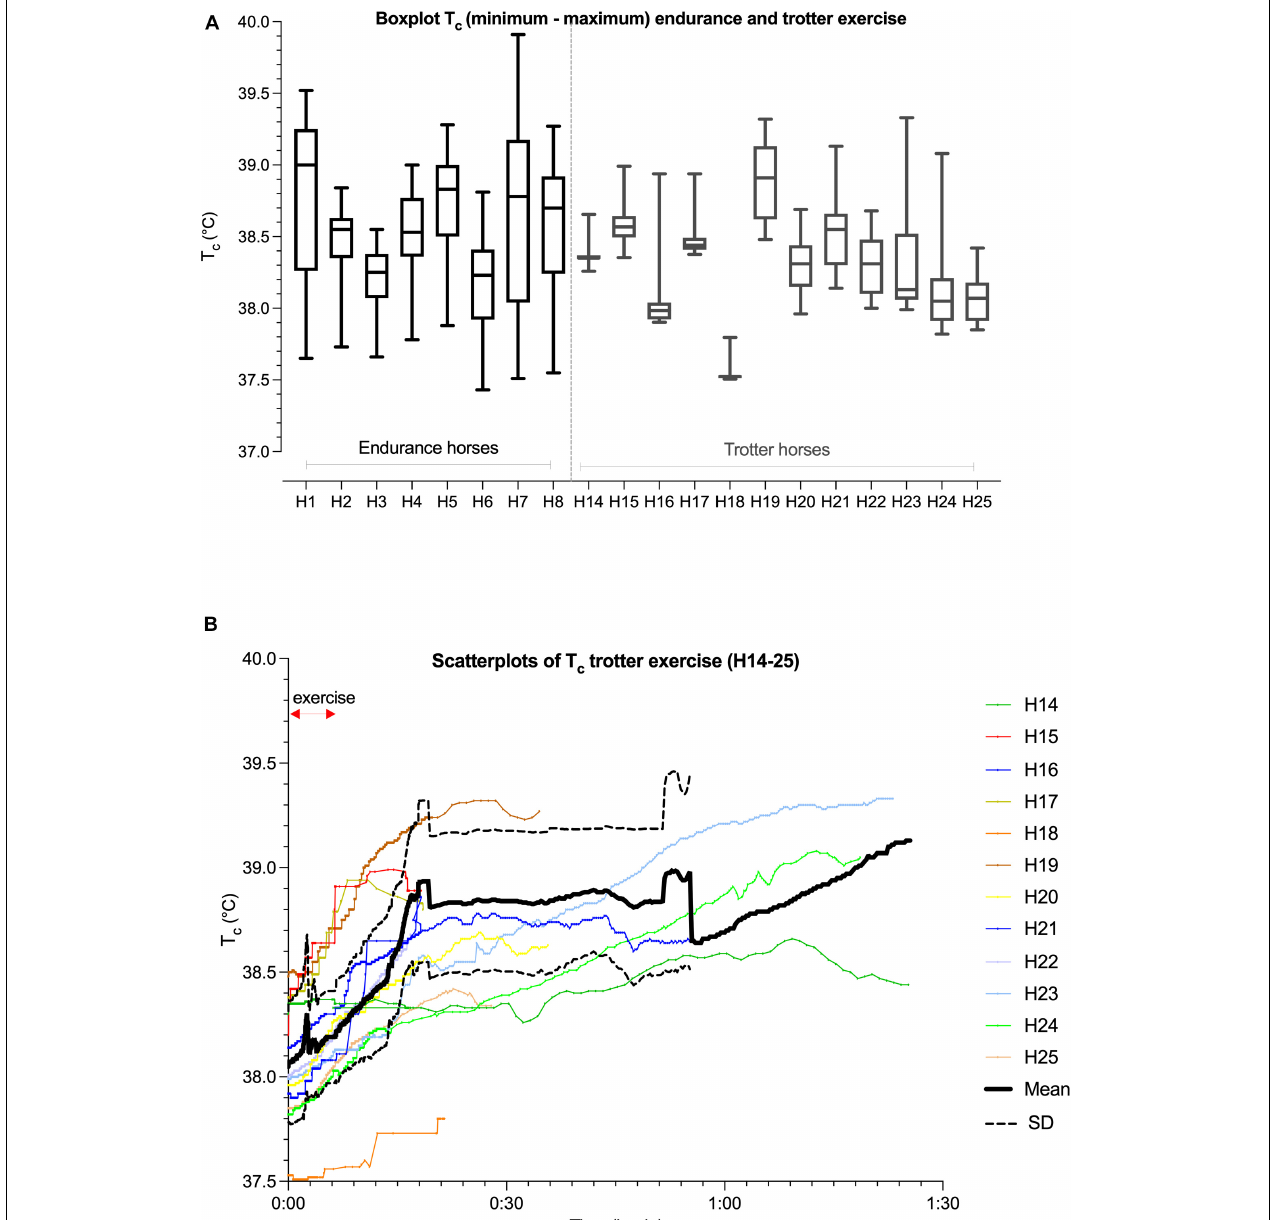
FIGURE 3 | Box and whisker plots demonstrating median (solid line), interquartile range (identified by rectangular area), and minimum to maximum (max) ranges of data (whiskers or error bars) of boxplots of T c ( ◦ C) in horses (H; horse number) in endurance (H1–H8) and trotter (H14–H25) exercise (A) . Scatterplots with T c ( ◦ C; left y -axis) over time [duration of exercise in hours (h) and minutes (min)] ( x -axis) in trotter horses (H14–25) and its mean (thick black line) ± SD (dotted black line, calculated when n > 3 horses) during high intensity trotter exercise over time (B)